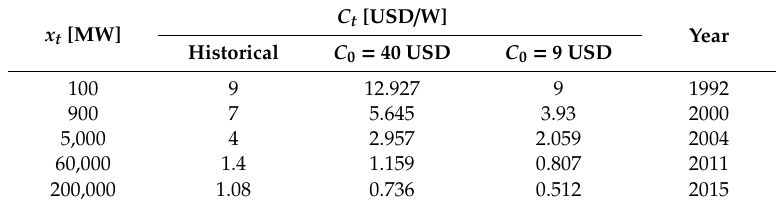
Table 3. Comparison of historical and calculated data for PV. Own work based on [54,55].